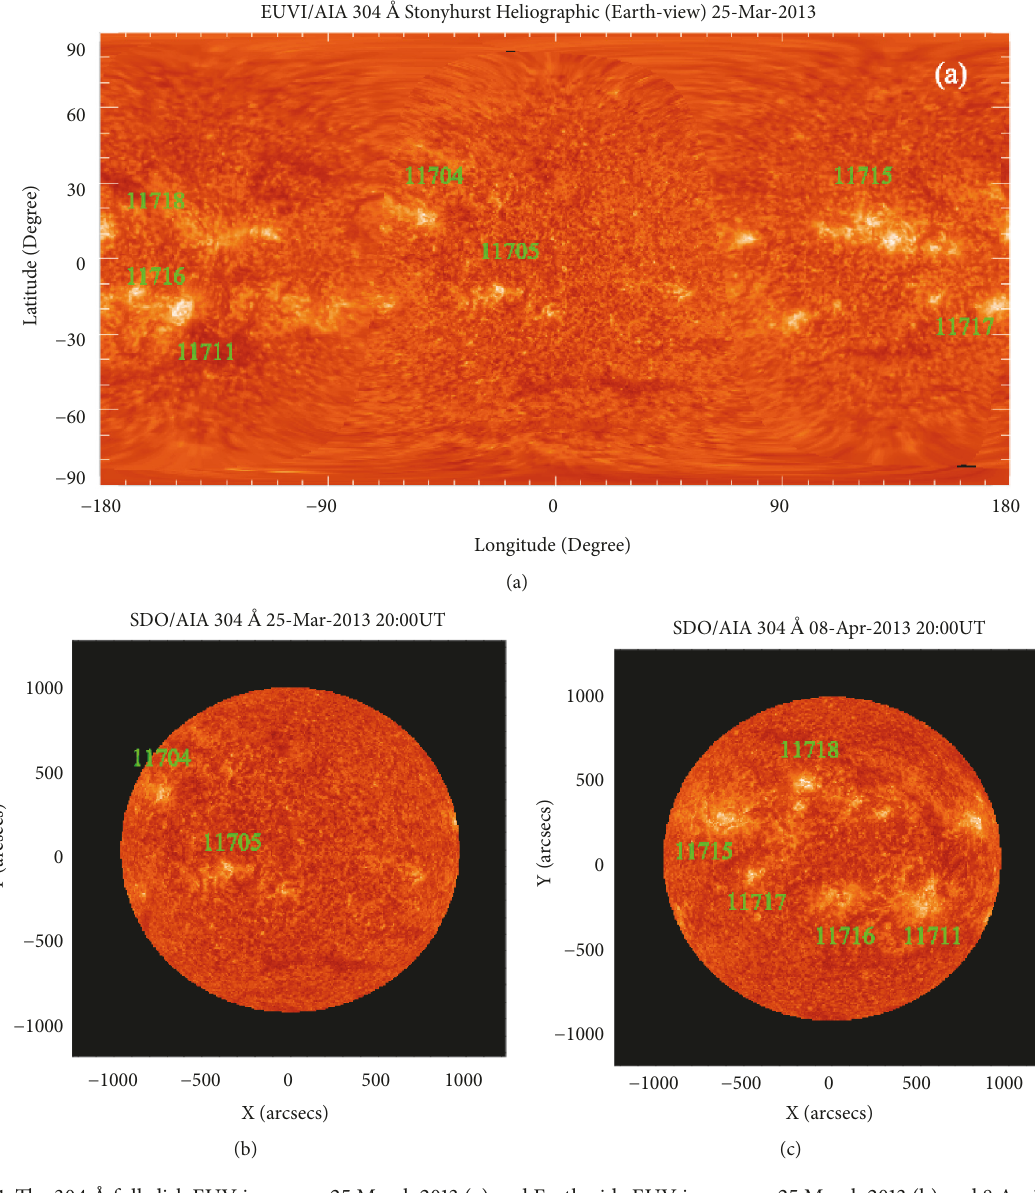
27-day values of F 10.7 based on the solar full-disk EUV images. Moreover, to gain a more satisfactory predictive precision, combining the upcoming 1-2 days predictive